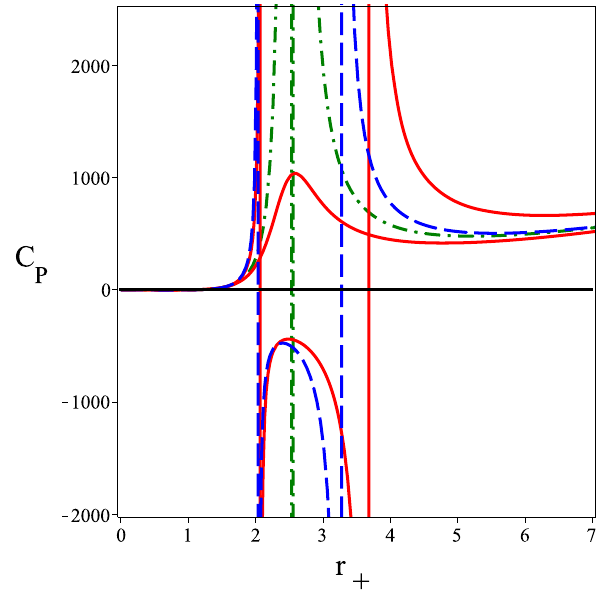
Fig. 4 The behavior of C P in terms of r + for P = 0 . 002 , 0 . 002669 , 0 . 003 (right to left) and Q = 1, and for RN-AdS metric (dashed line) and for P = 0 . 002669, Q = 1